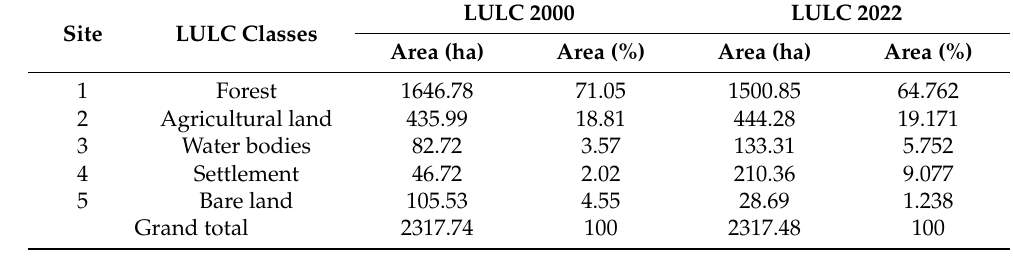
Table 3. Current land use and land cover (LULC) change in Ghodaghodi Lake Complex, Nepal, between 2000 (April) and 2022 (April).